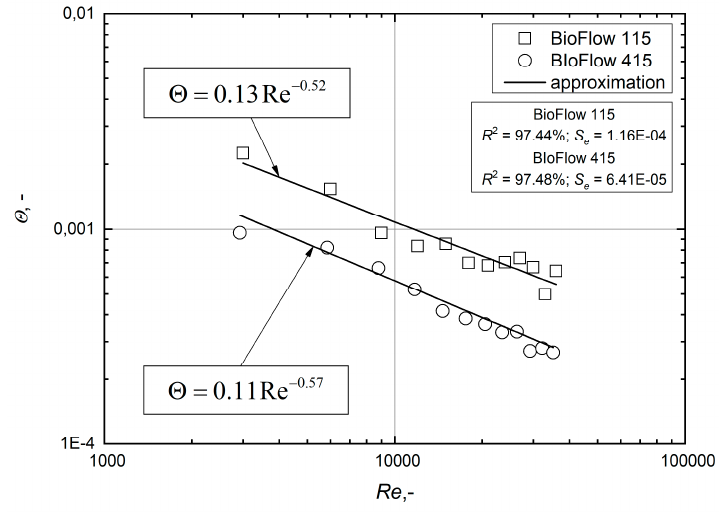
Figure 7. Dependence Θ = f (Re) for the tested bioreactors.